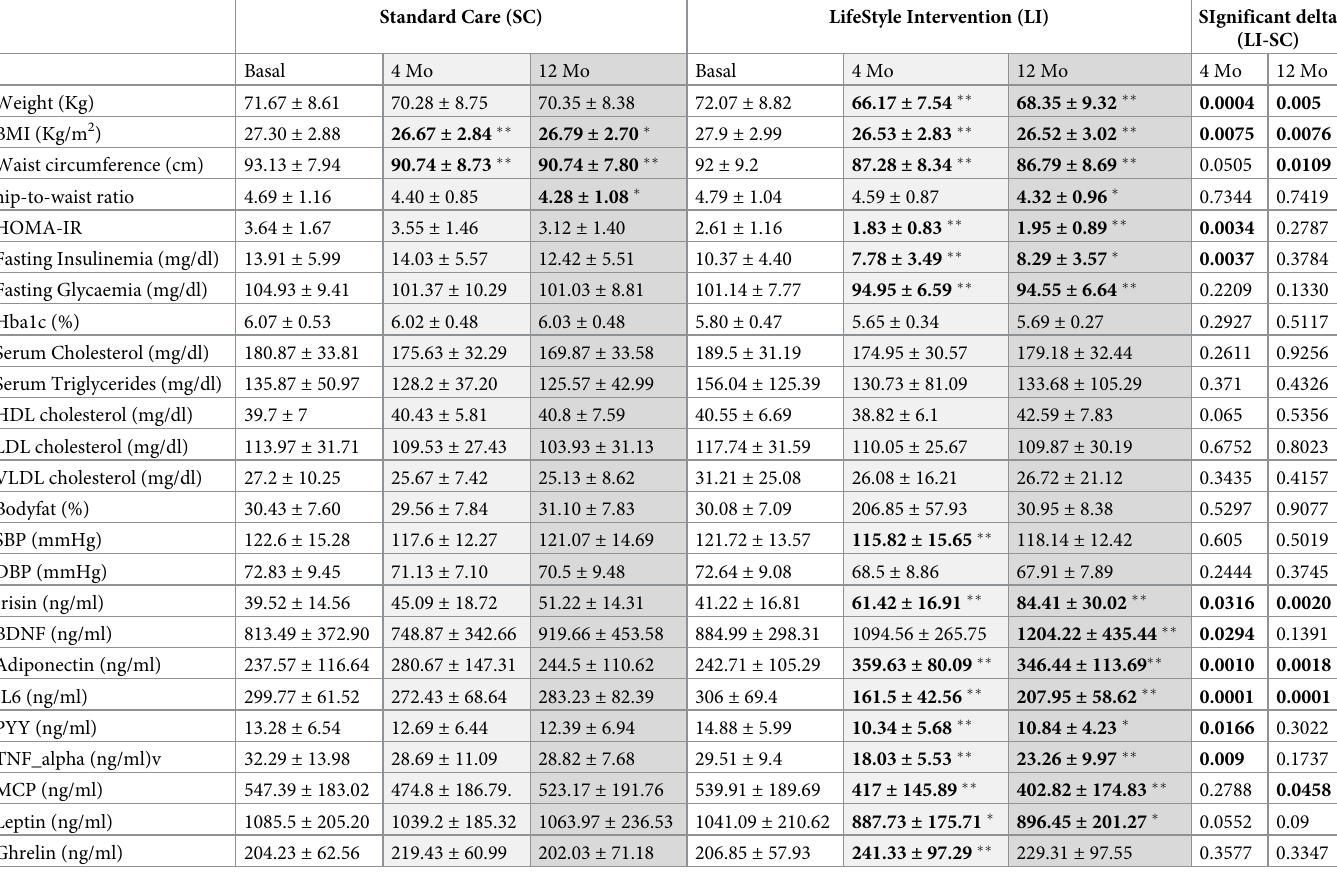
Table 1. Validation of the lifeStyle intervention protocol. Anthropometrics and metabolic parameters of the subjects involved in the Standard Care (SC) or LifeStyle Intervention protocol (LI) determined at 4 months and at 8 months